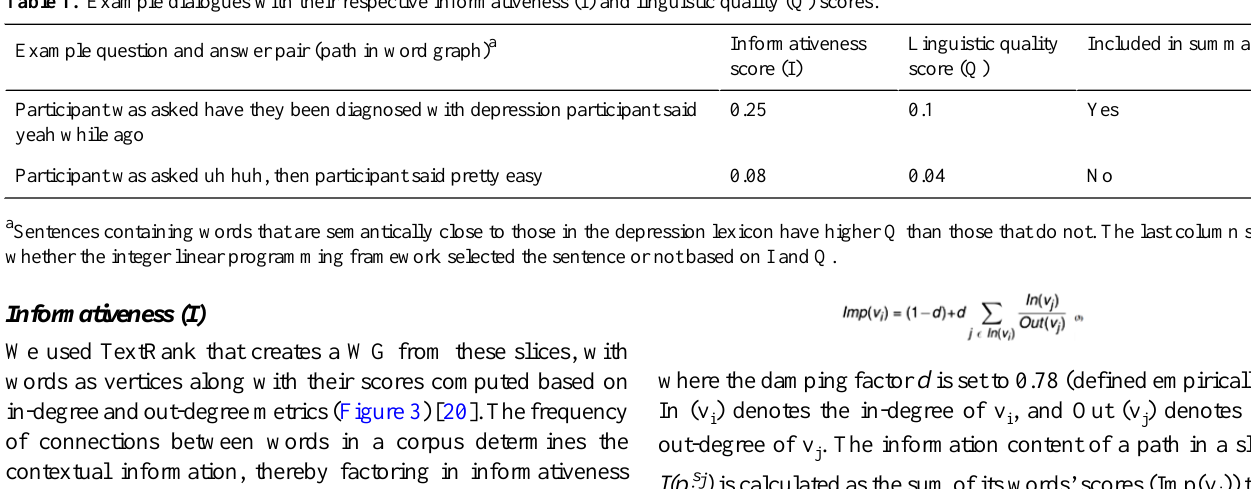
Table 1. Example dialogues with their respective informativeness (I) and linguistic quality (Q) scores.